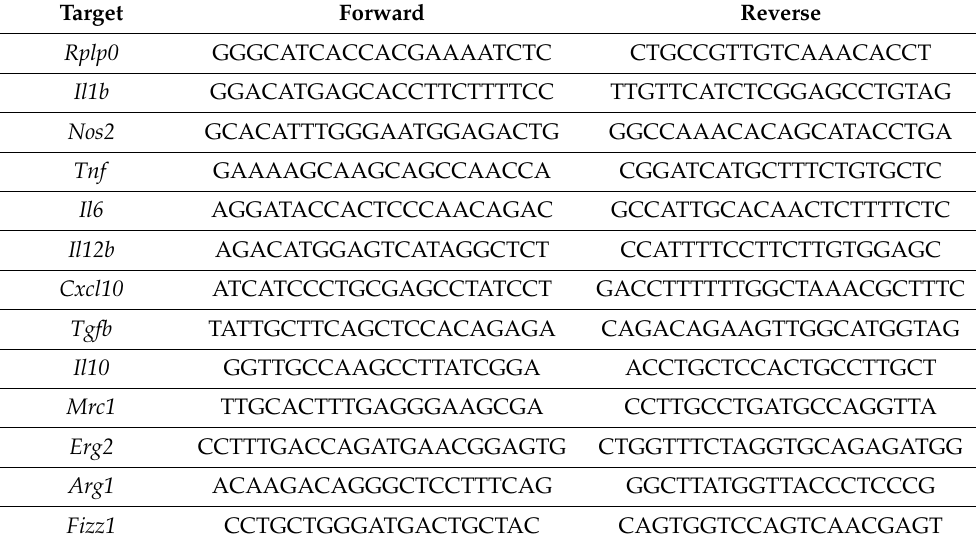
Table 1. Primers used for